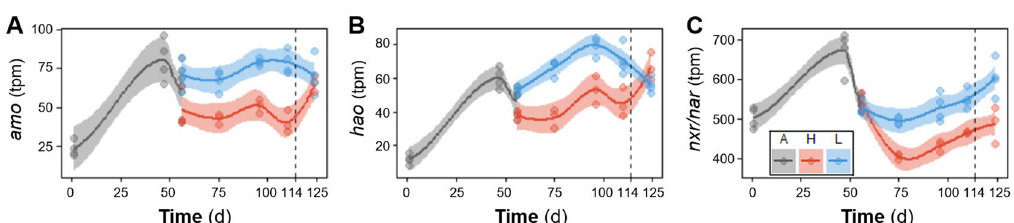
Figure 4. Temporal dynamics of nitrification genes amo ( A ), hao ( B ) and nxr (together with nitrate reductase genes, nar ) ( C ), measured as relative abundances of transcripts per million (tpm) from assembled metagenomics data. Each point represents a different reactor on a given day. Phases: A, acclimation (n = 4); L, low F:M–C:N (n = 4); H, high F:M–C:N (n = 3). Vertical dashed line indicates the shift from high to low F:M–C:N. Lines refer to polynomial regression fitting, while shaded areas represent 95% confidence